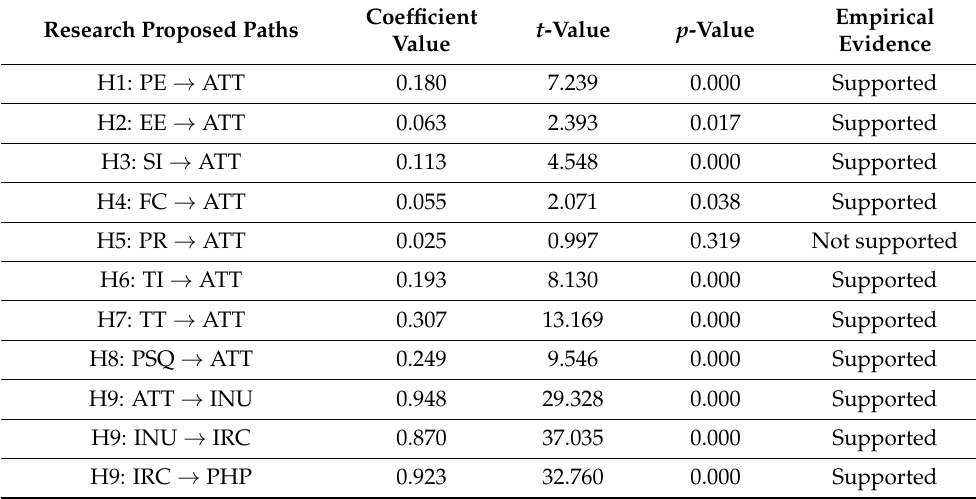
Table 6. Summary of proposed results for the theoretical